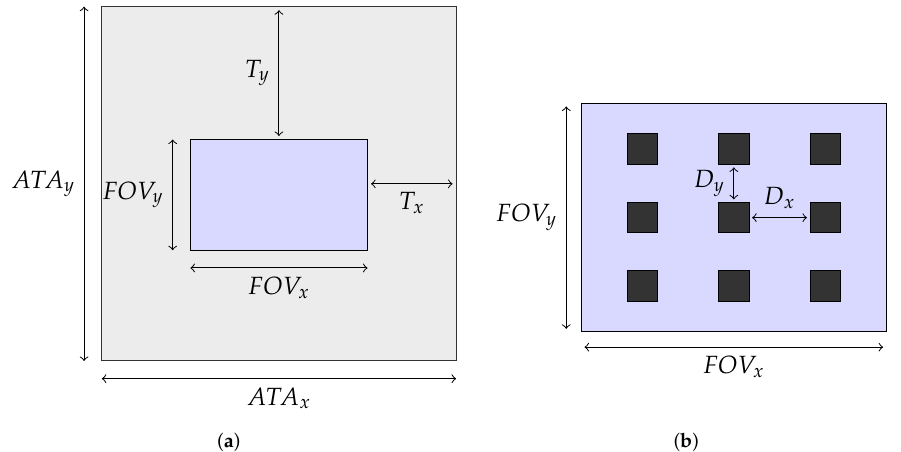
Figure 7. Graphical representation of the camera’s field of view (blue), the AprilTag array (gray), AprilTags (black), and their arrangement in the the camera’s field of view: ( a ) Parameters determining array dimensions, and ( b ) AprilTag